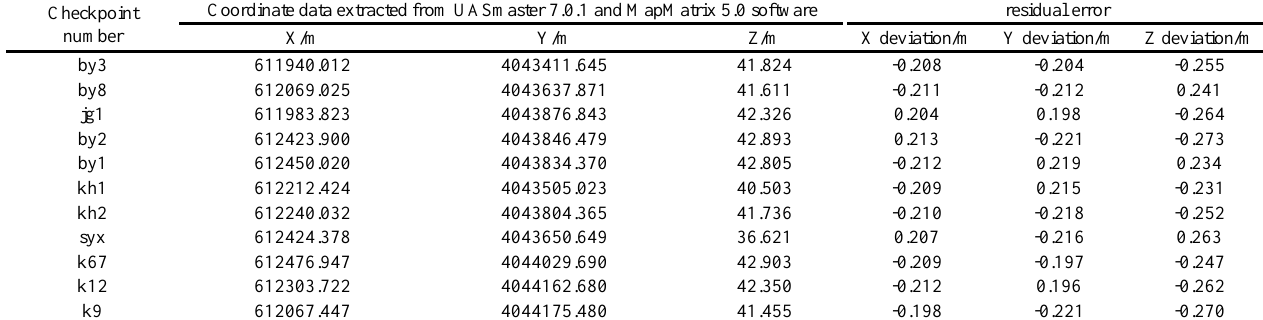
Table 7 Scheme Ⅱ experimental